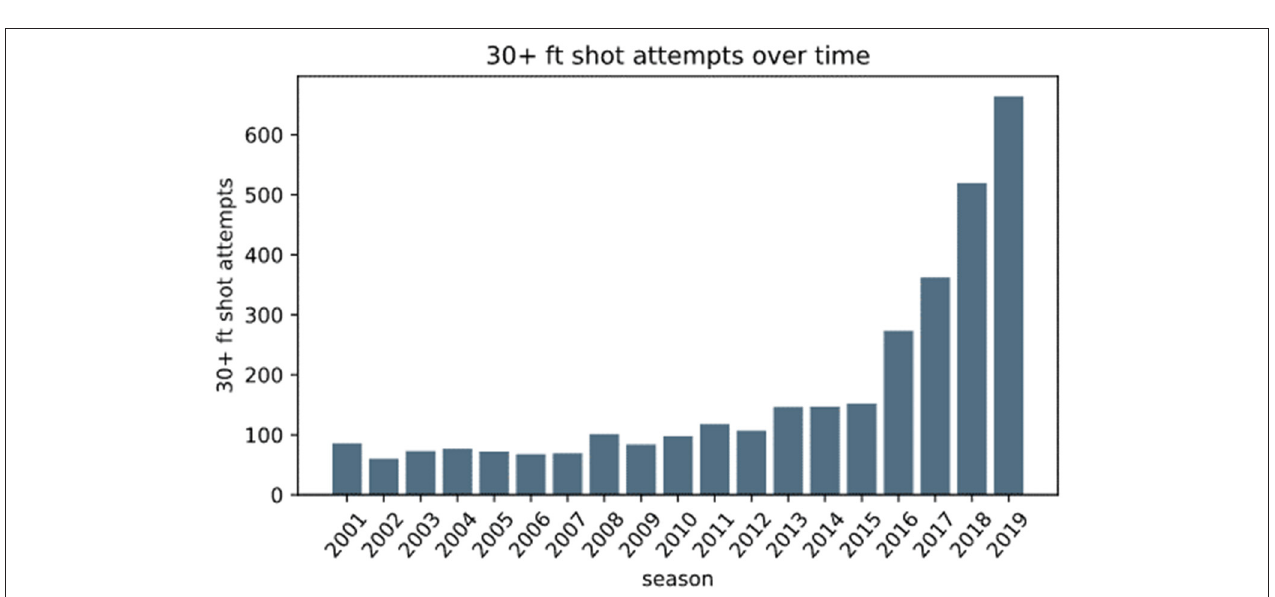
FIGURE 4 | The adoption rate of each test type (bar graph/left-axis) and the total number of tests conducted (line graph/right-axis) for the three categorized types (defensive vs. 180 ◦ -turn vs. cutting: (A) and the two subcategorized types (pre-planned vs. reactive: (B) shown at ten-year-intervals. Note that reactive types were only used in the cutting type in 2000s and 2010s (detailed in Table 1 ).